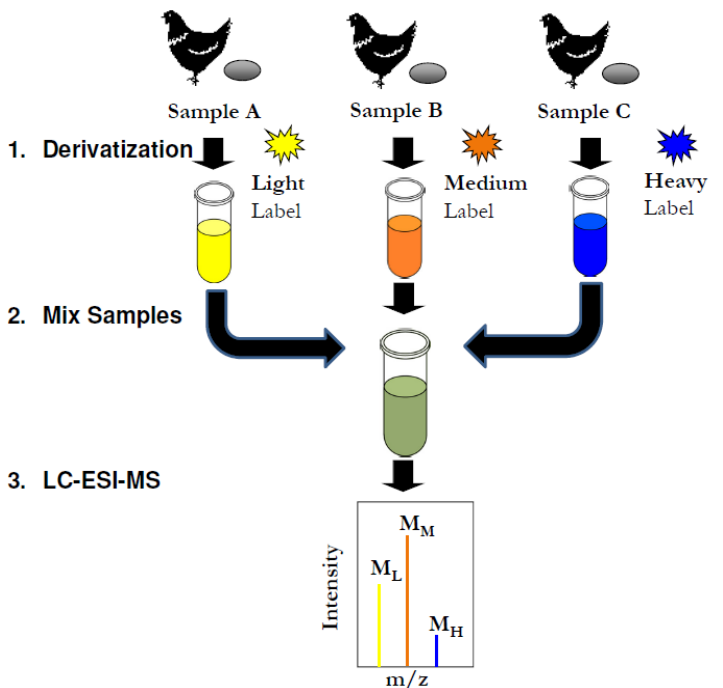
Figure 1. Multiplex relative quantification with isotopic labeling. Fatty Acids are extracted from three different egg samples before labeling of each with a unique form of cholamine (light, medium, or heavy). The resulting isotopically labeled fatty acids are combined and analyzed by LC-ESI-MS wherein relative quantification can be made from the peak intensities of the fatty acids from the individual